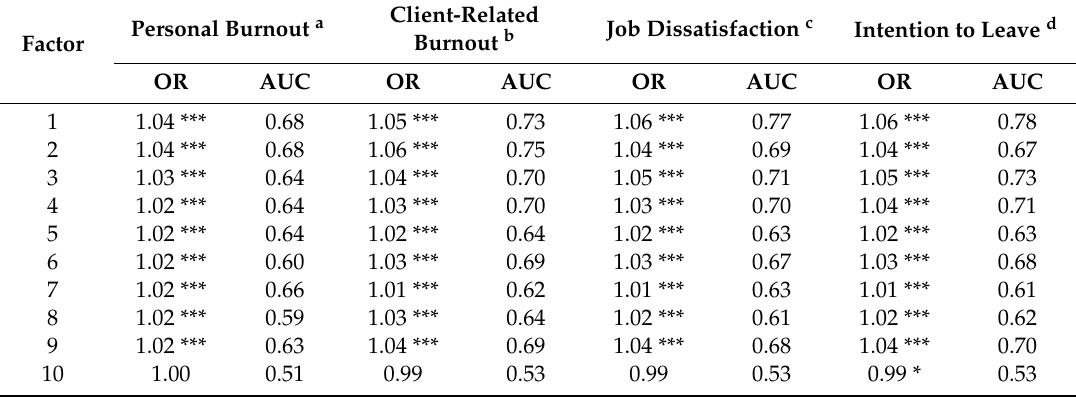
Table 3. Personal burnout, client-related burnout, job dissatisfaction, and intention to leave as indicators for item retention on the NOSS (N =